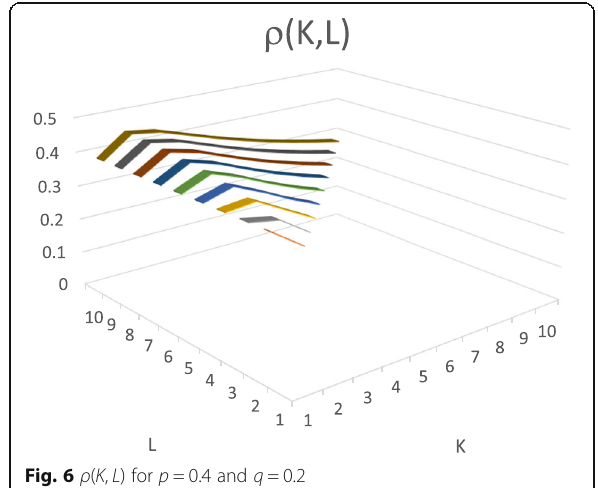
Fig. 6 ρ ( K , L ) for p = 0.4 and q = 0.2